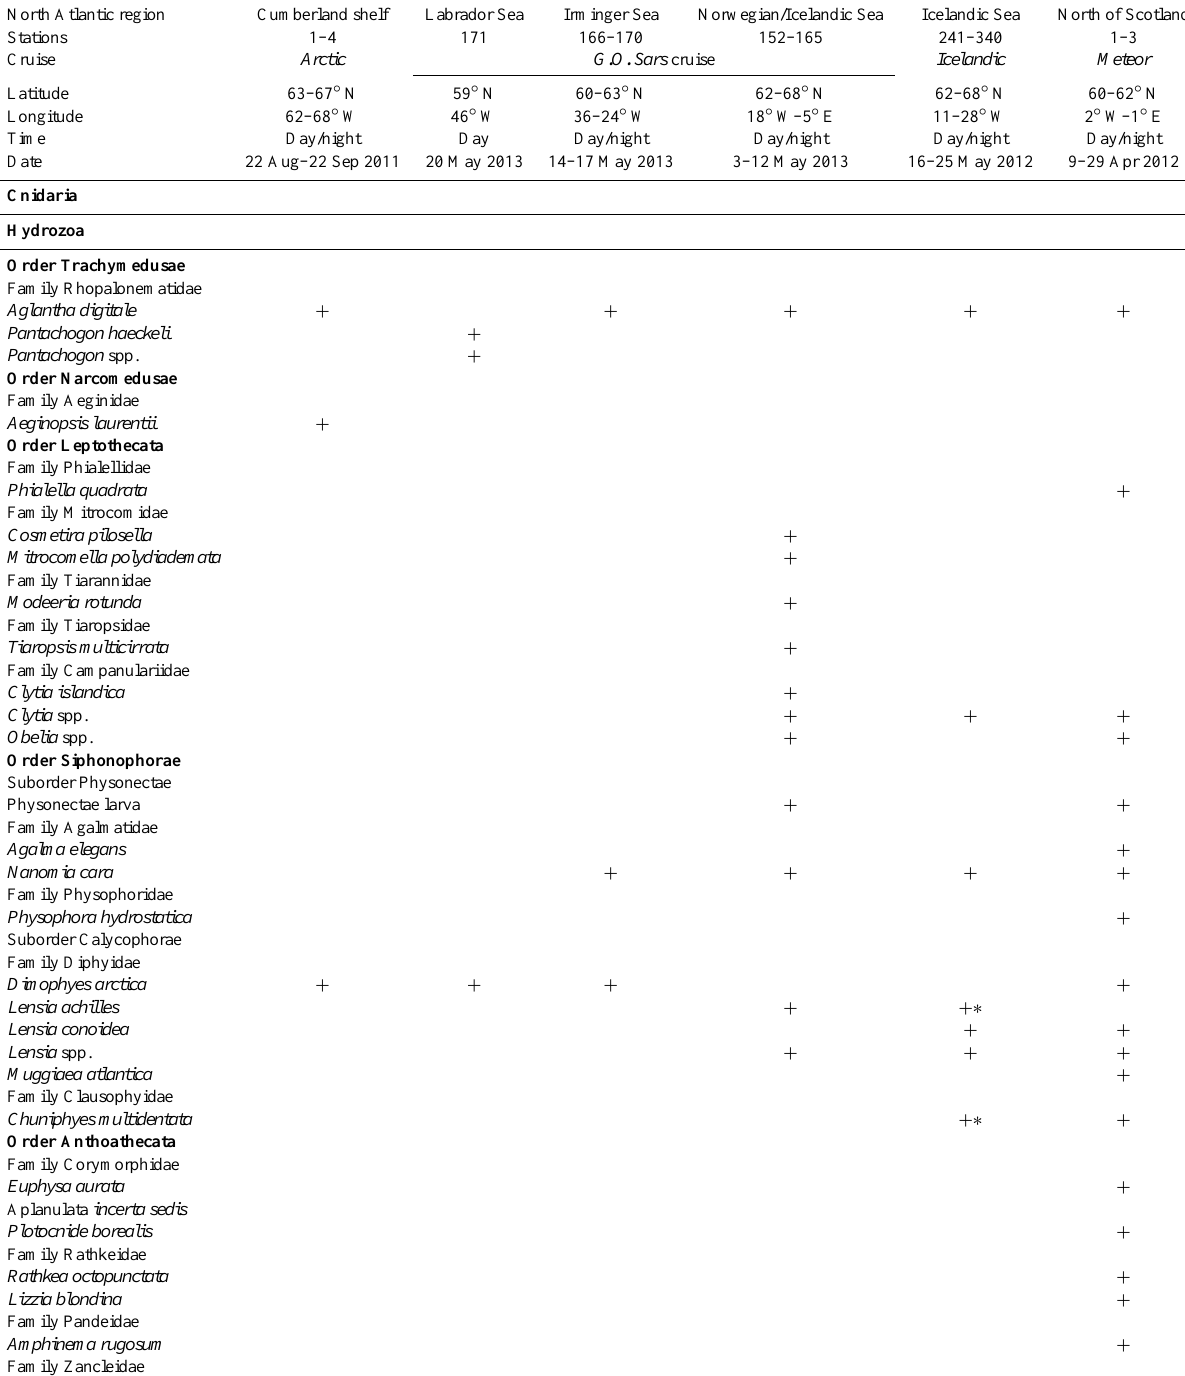
Table 4. Jellynet data set. List of jellyfish taxa collected in epipelagic waters (0–200m) in different North Atlantic regions. *Taxon found only in samples collected at 0–400m depth. Data from Licandro et al.